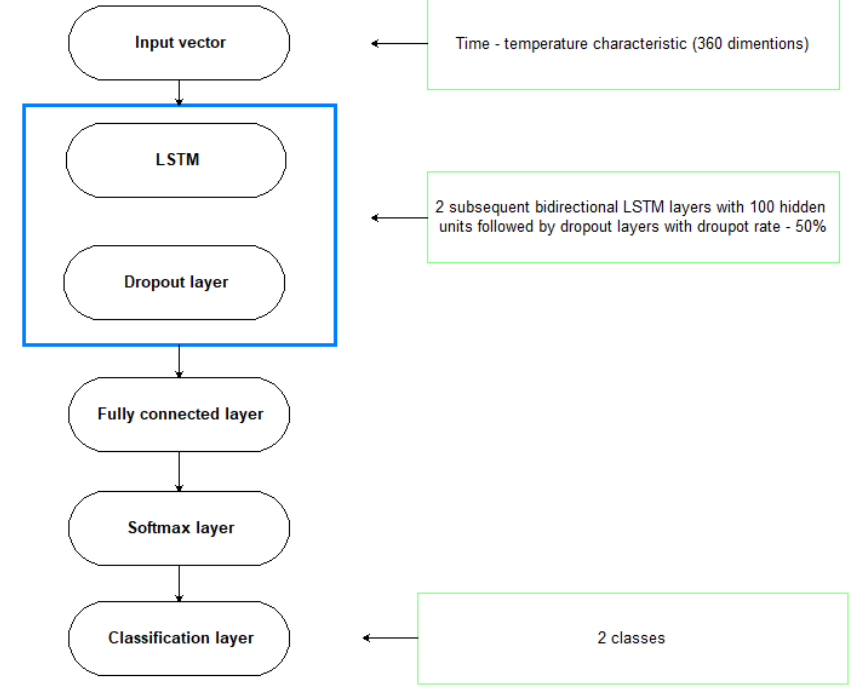
Figure 16. The architecture of the proposed neural network.